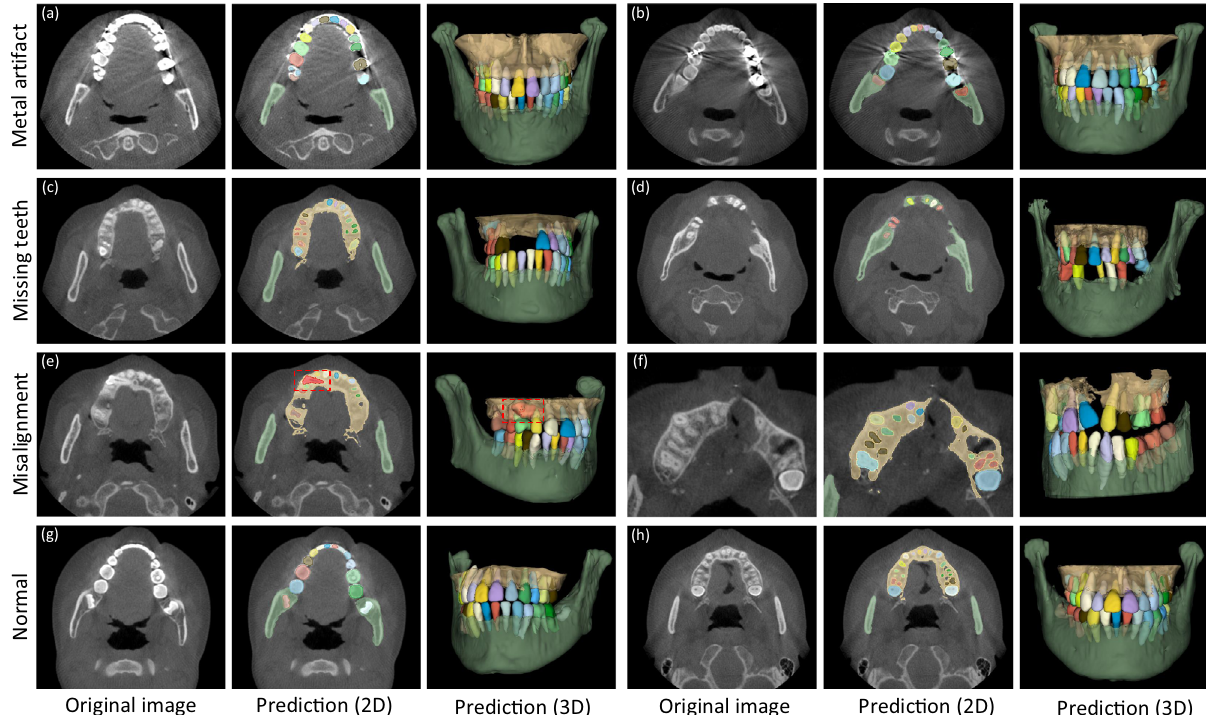
Fig. 4 Typical tooth and bone segmentation results from the CBCT images with dental abnormalities. Images with metal artifacts ( a , b ), missing teeth ( c , d ) and misalignment problems ( e , f ), and without dental abnormality ( g , h ).